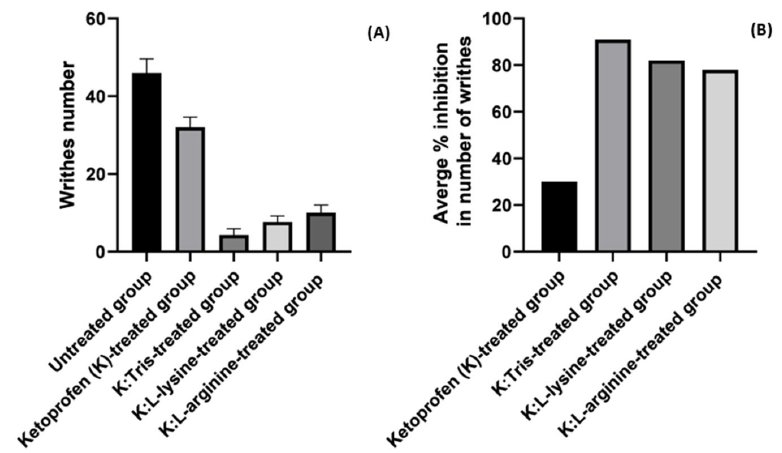
Figure 7. ( A ) The number of writhes and ( B ) average percentage (%) inhibition for ketoprofen and ketoprofen with respect to the three basic excipient coprecipitated mixtures .